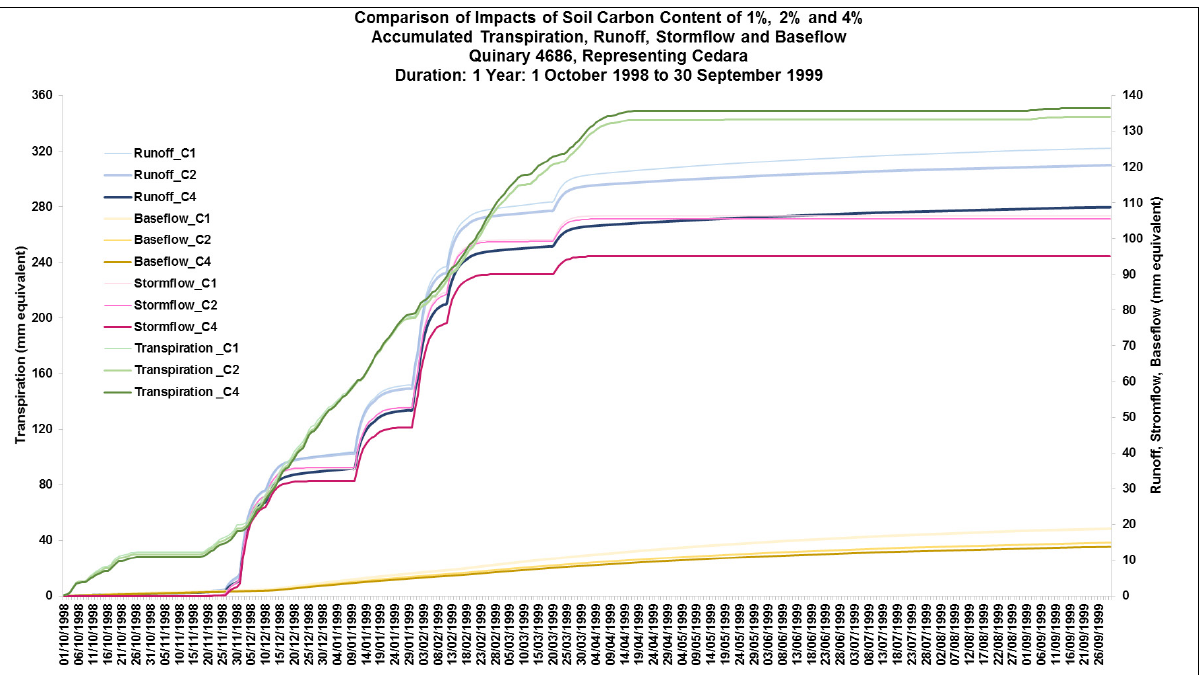
Figure 4: Daily accumulated transpiration (left y -axis), as well as accumulated runoff, stormflow and baseflow (right y -axis, all in mm) for a one-year period for the C , C and C scenarios, using Quinary Catchment 4686 representing Köppen Climate Zone Cwb at 1 2 4